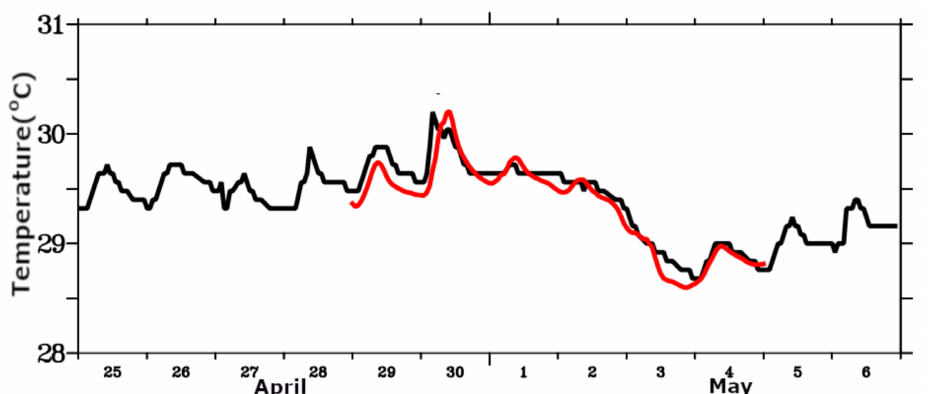
Figure 5. Comparison of sea surface temperature ( ◦ C) simulated by model (red) against drifting buoy measured (black). The location of the drifting buoy is marked in Figure